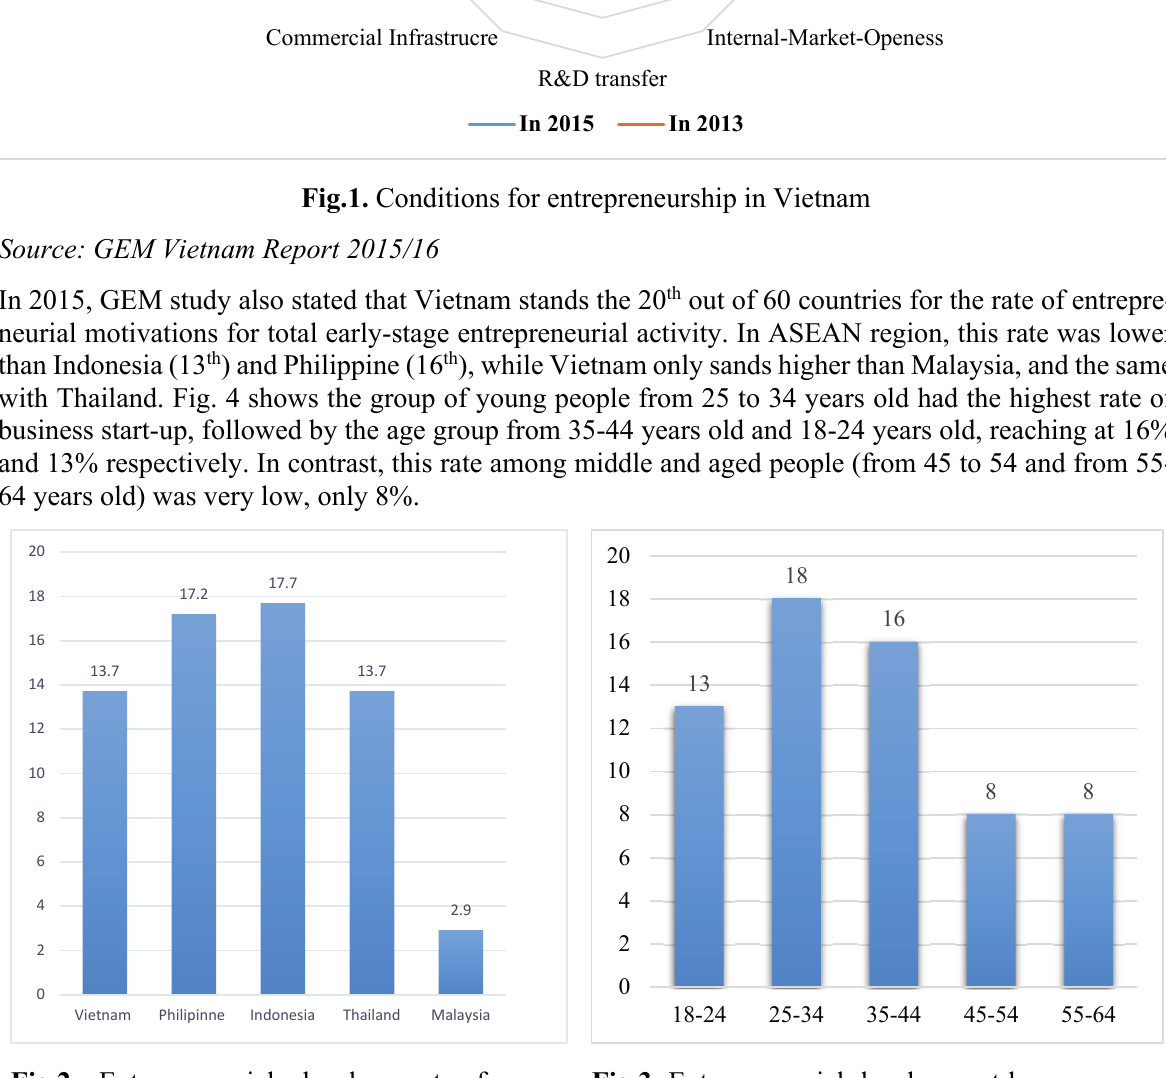
Fig.3. Entrepreneurial development by age group in 2015 (unit: